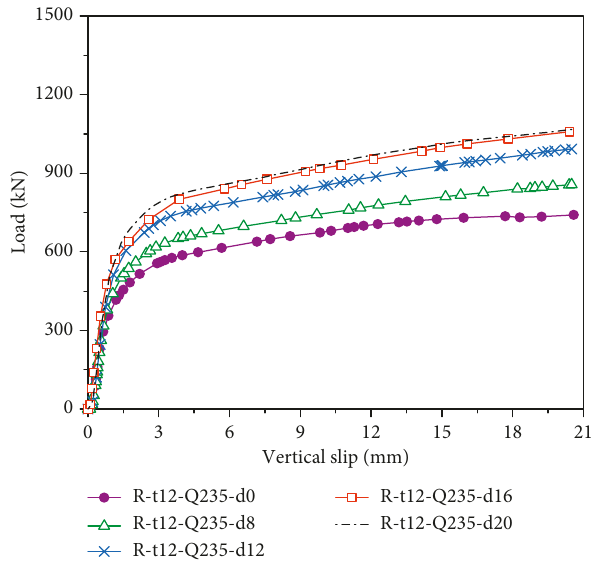
Figure 15: Load-slip curves for PBL with different rebar diameters.